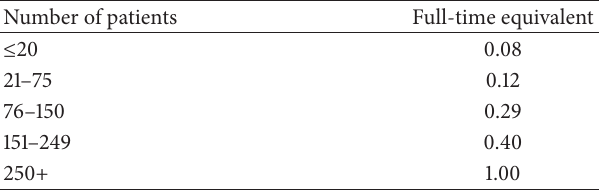
Table 8: Respiratory technician.